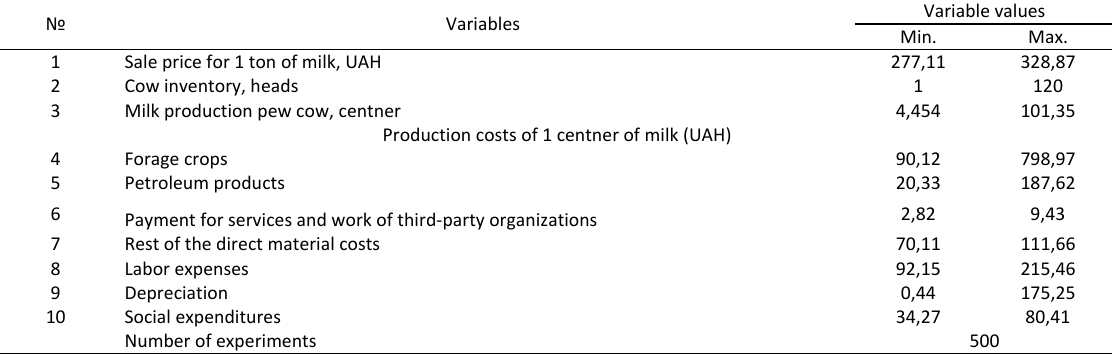
Table 1: Source data for simulation modeling of milk production in researched agricultural enterprise by the Monte Carlo method №